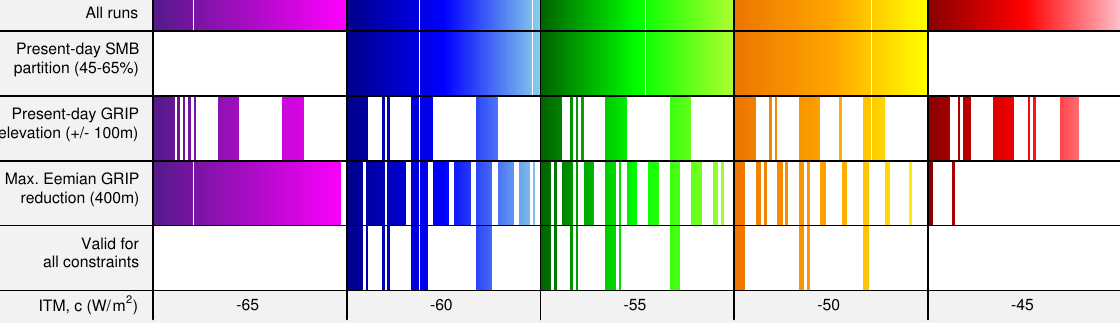
Fig. 6. Schematic table of constraints applied to the paleo simulations of the Greenland Ice Sheet. Each color band contains 72 simulations, corresponding to the choice of melt parameter c , where lighter shades correspond to more sensitive secondary parameter combinations for added distinction (this color scheme is used for all plots). The first row shows all simulations. The middle rows correspond to specific con- straints – so if a simulation is consistent with the constraint, it is plotted in that row (otherwise, white regions indicate rejected simulations). The last row shows the simulations that were consistent with all constraints and thus are considered valid.